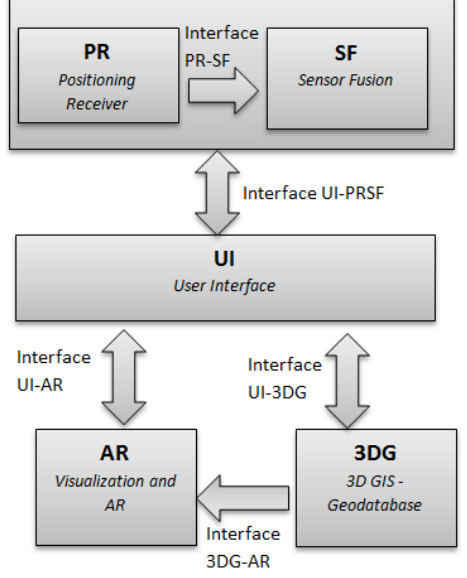
Figure 4: UI view of LARA project